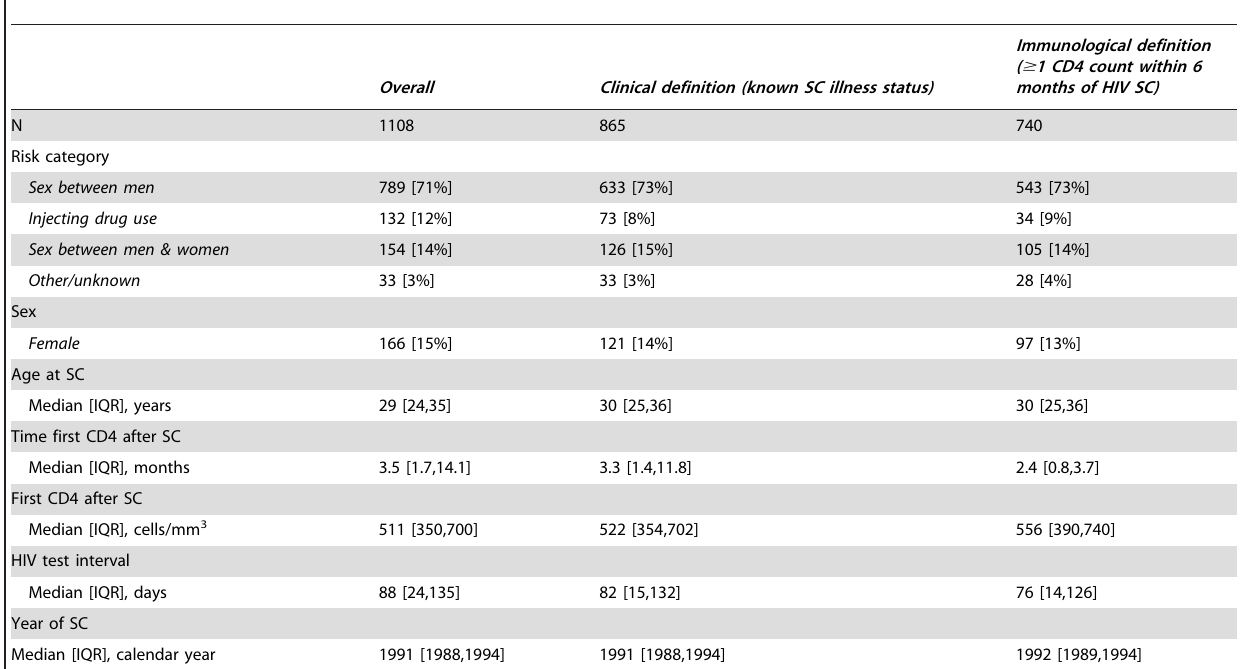
Table 1. Characteristics of included patients overall and separately for clinical and immunological definitions of severe primary HIV infection